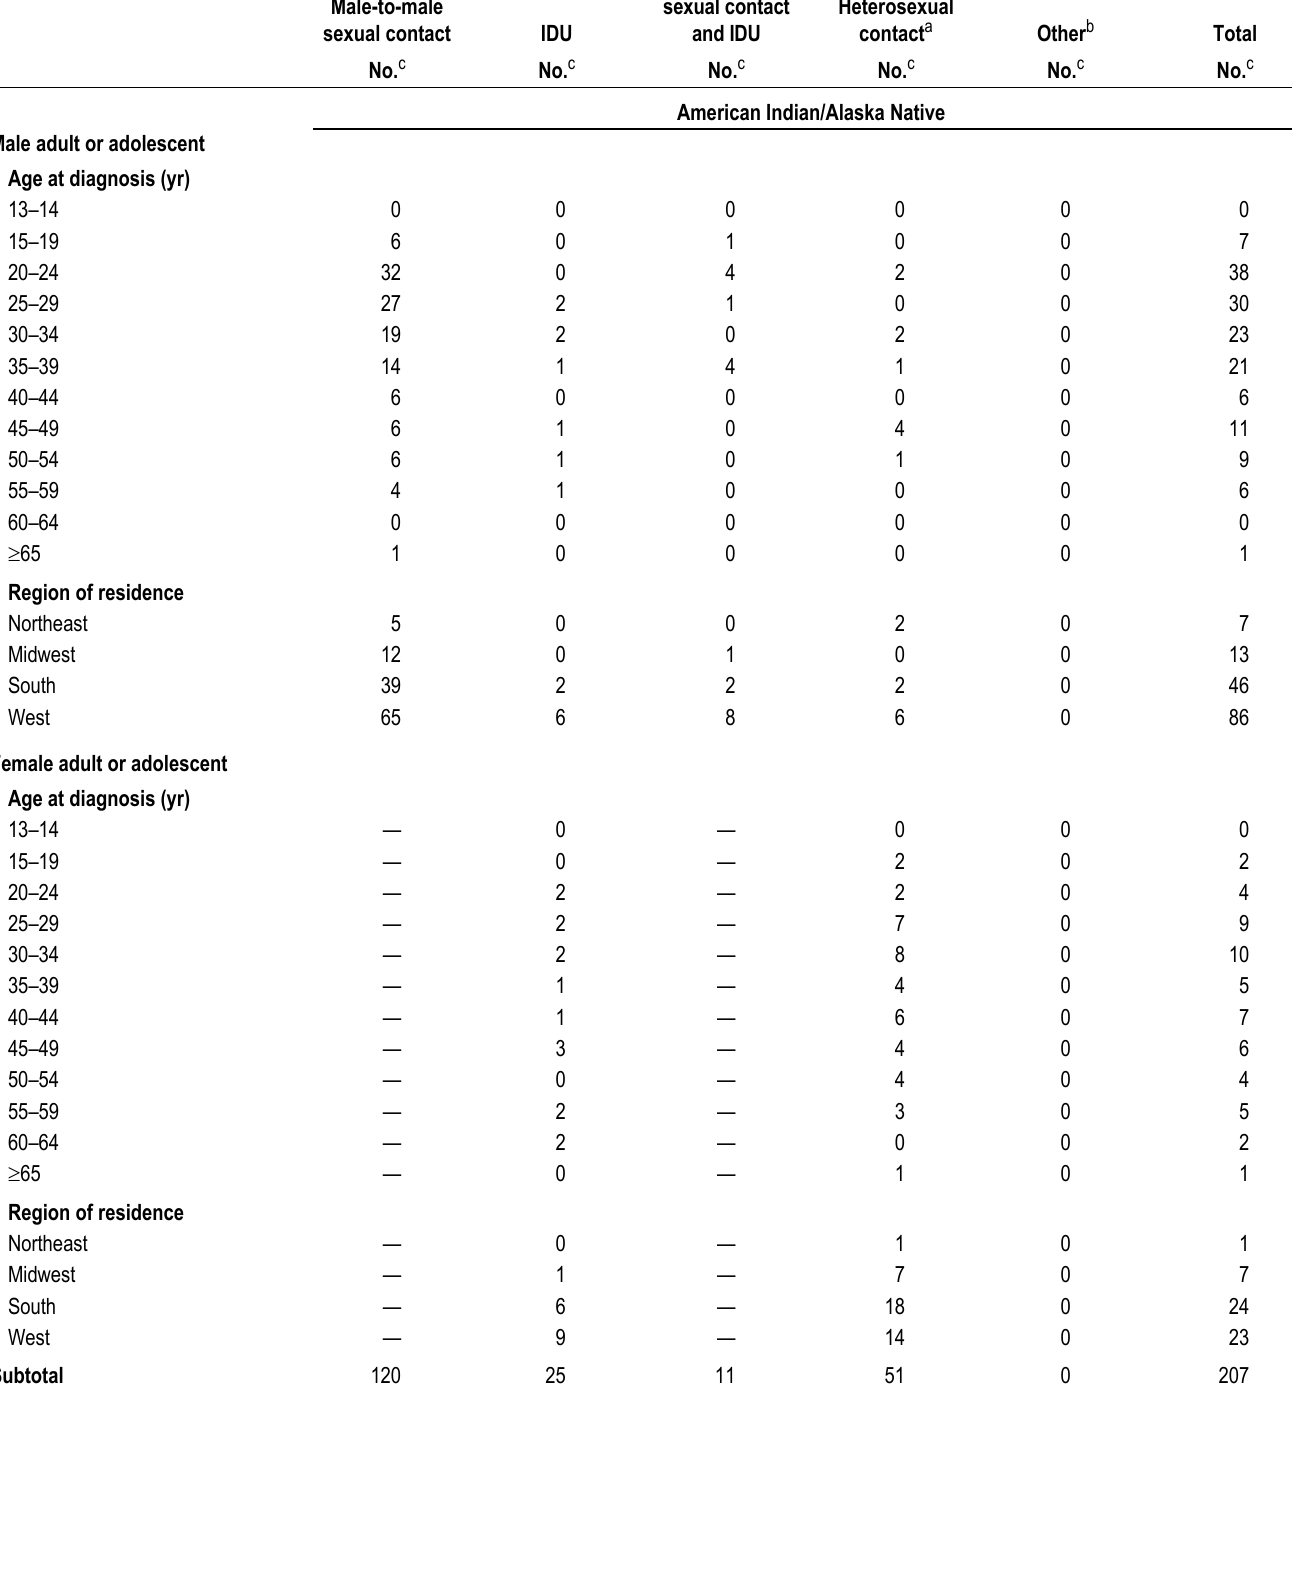
Male-to-male sexual contact IDU